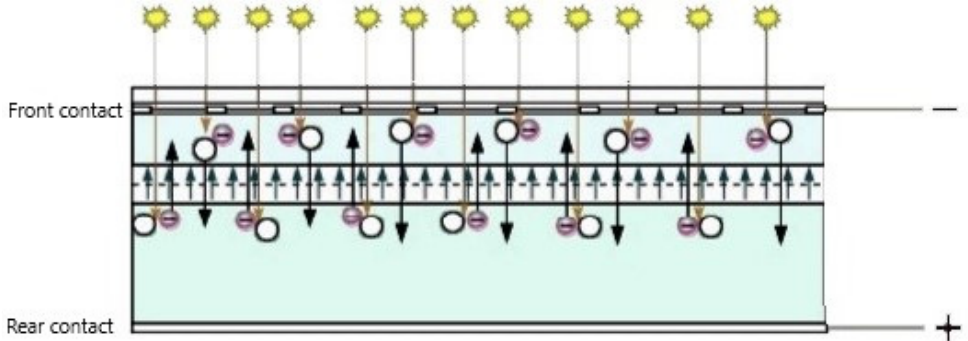
Figure 4. The flow of majority carriers in a forward-biased diode.